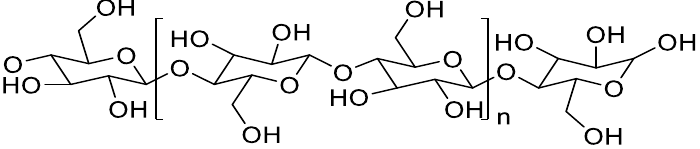
Figure 1. Molecular structure formula of cellulose (Note: n is the degree of polymerization).